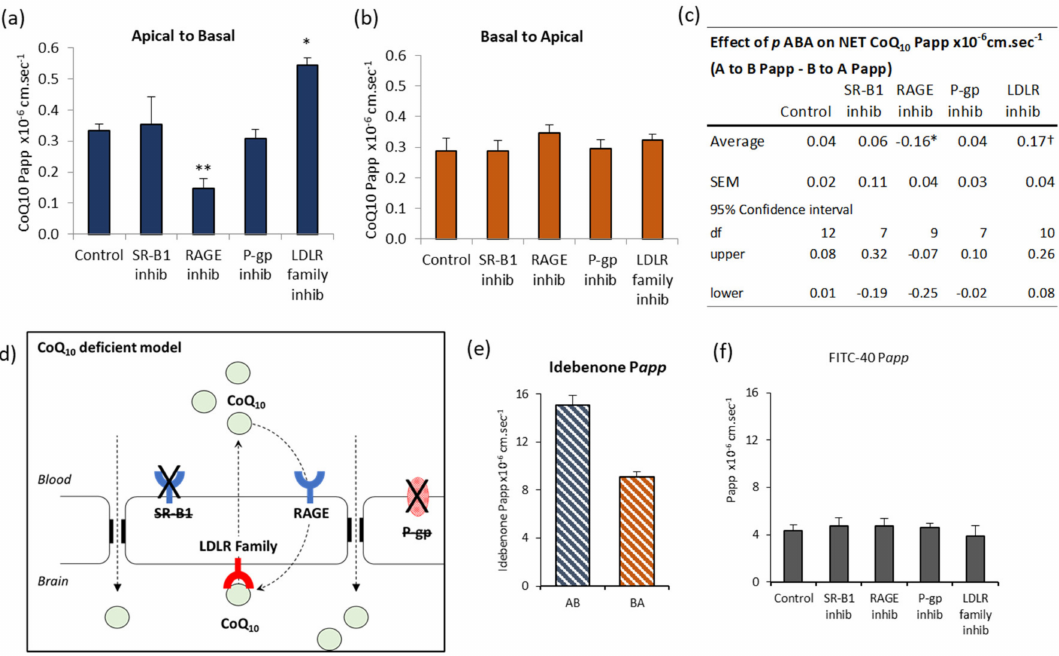
Figure 5. p ABA treated bEnd.3 cells: E ff ect of transport inhibitors on CoQ 10 transport. CoQ 10 (pre-incubated in serum) transport across p ABA treated (1 mM; 5 days) bEnd.3 cells on Transwell filters assayed over 60 min. Inhibitors added apically and basally two hours before assay were BLT-1 (10 µ M) for SR-B1, FPS-ZM1 (1 µ M) for RAGE, RAP (0.5 µ M) for LRP-1 / LDLR and verapamil (0.1 mM) for p-glycoprotein. Apparent permeability, P app , shown for ( a ) Apical to Basal CoQ 10 transport, ( b ) Basal to Apical CoQ 10 transport. ( c ) The “net” transport of CoQ 10 across bEnd.3 cells, calculated from the di ff erence between A to B transport (blood to brain) and B to A transport (brain to blood). “Net” transport in p ABA treated control cells was Apical to Basal, toward the brain side. * Treatment with RAGE inhibitor, FPS-ZM1 (1 µ M), abolished “net” A to B transport. † Treatment with LRP-1 / LDLR inhibitor RAP (0.5 µ M), enhanced “net” + ve transport toward the brain side (A to B). The SR-B1 and p-glycoprotein inhibitors BLT-1 (10 µ M) and Verapamil (0.1 mM), had no significant e ff ect on “net” transport. ( d ) Schematic summary of CoQ 10 transport across a CoQ 10 deficient BBB. “Net” transport shifts toward to the brain side. Uptake via RAGE but SR-B1 is absent. Leaky tight junctions facilitate extra transfer across the BBB. E ffl ux via LRP-1 is retained. ( e ) Transport of the CoQ 10 analogue, idebenone. Apical to Basal transport exceeded Basal to Apical, meaning there was “net” transport toward the brain. n = 6; values are mean ± SEM * p < 0.05. ( f ) FITC-40 Apical to Basal transport; n = 4–7; values are mean ± SEM; * p < 0.05, ** p < 0.01; ANOVA single factor; post-hoc